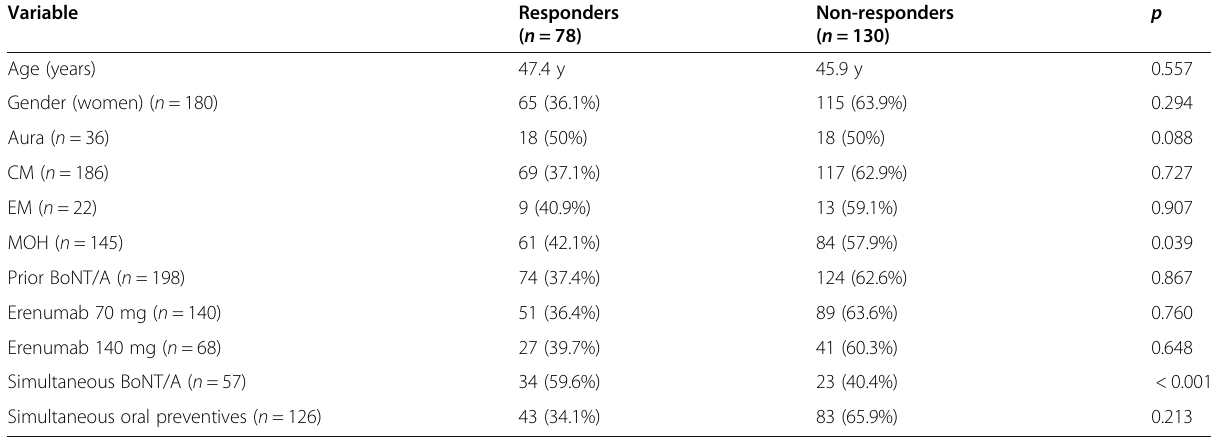
Table 2 Predictive factors of good